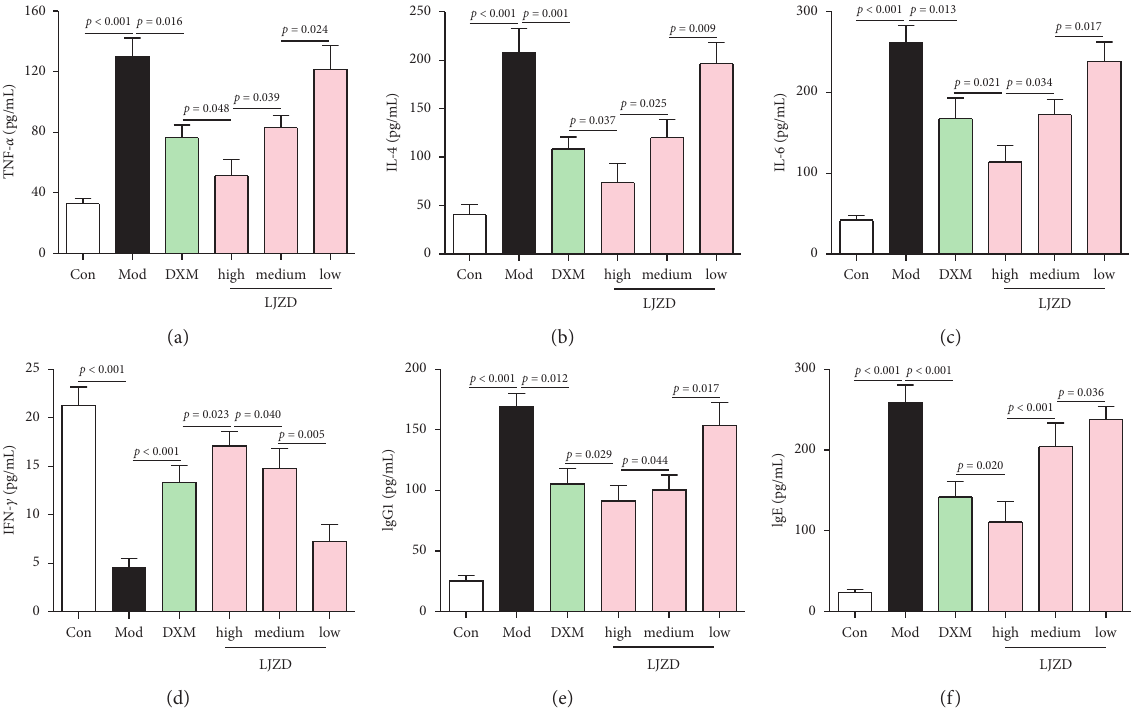
Figure 3: LJZD regulated TNF- α , IL-4, IL-6, IFN- c , lgG1, and lgE secretion in asthmatic mice. The protein levels of TNF- α (a), IL-4 (b), IL-6 (c), and IFN- c (d) in and serum of the Con, Mod, DXM, and high-, medium-, and low-dosage LJZD groups were detected by ELISA. The levels of lgG1 (e) and lgE (f) in serum of all the groups were also detected by ELISA. The results were shown as the mean ± SD from at least three independent experiments. TNF- α : tumor necrosis factor- α , IL: interleukin, IFN- c : interferon gamma, and ELISA: enzyme-linked immuno sorbent assay.